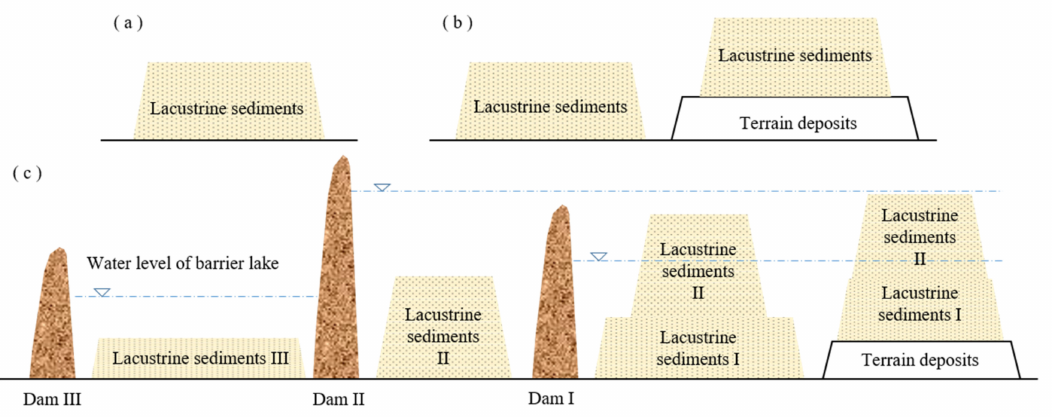
Figure 8. Diagram of the relationship between lacustrine sediments. ( a ) Situation 1; ( b ) Situation 2; ( c ) Situation 3 and Situation